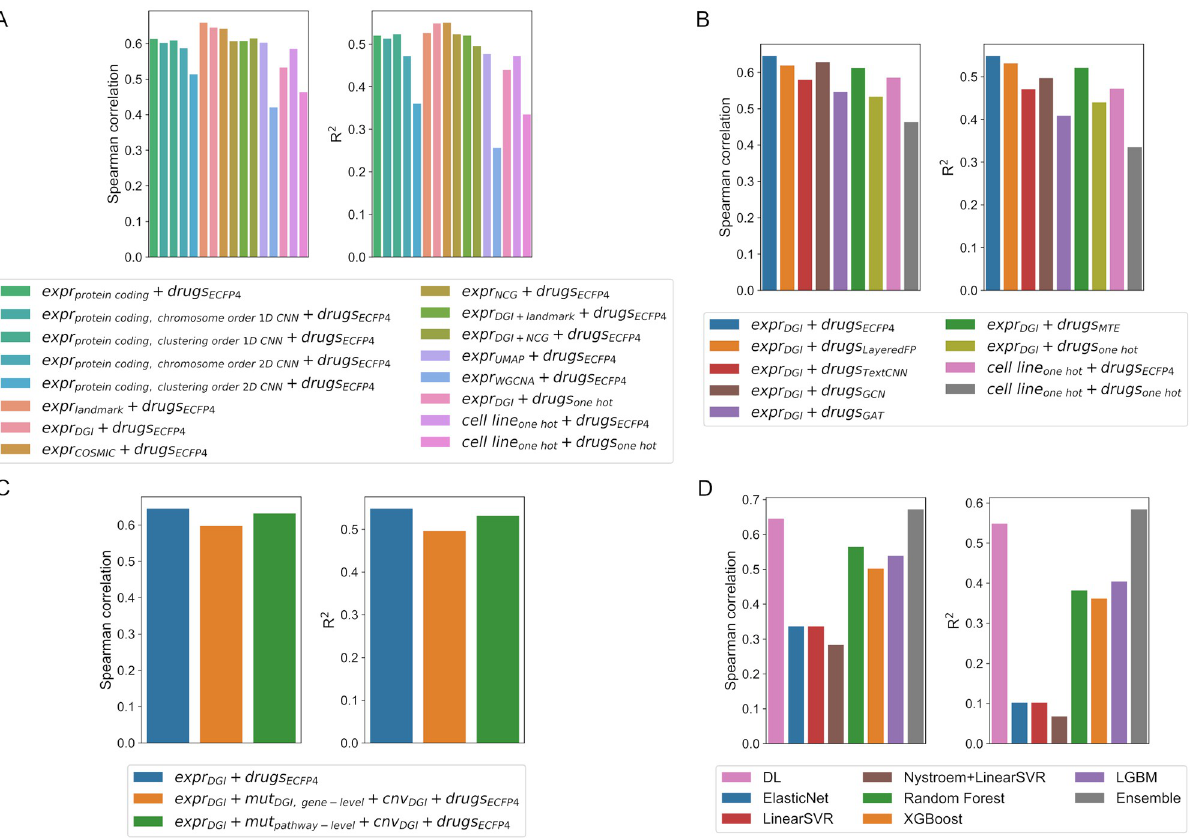
Fig 2. Performance scores (Spearman correlation—left—and R 2 —right) of the different models tested in this study. (A) Performance scores of models with different gene expression feature-encoding subnetworks. (B) Performance scores of models with different drug encoding subnetworks. (C) Performance scores of models trained with and without mutation ( mut ) and copy number variation ( cnv ) data in addition to gene expression and drug features. (D) Performance scores of non-DL models compared with one of the best DL models developed in this study.